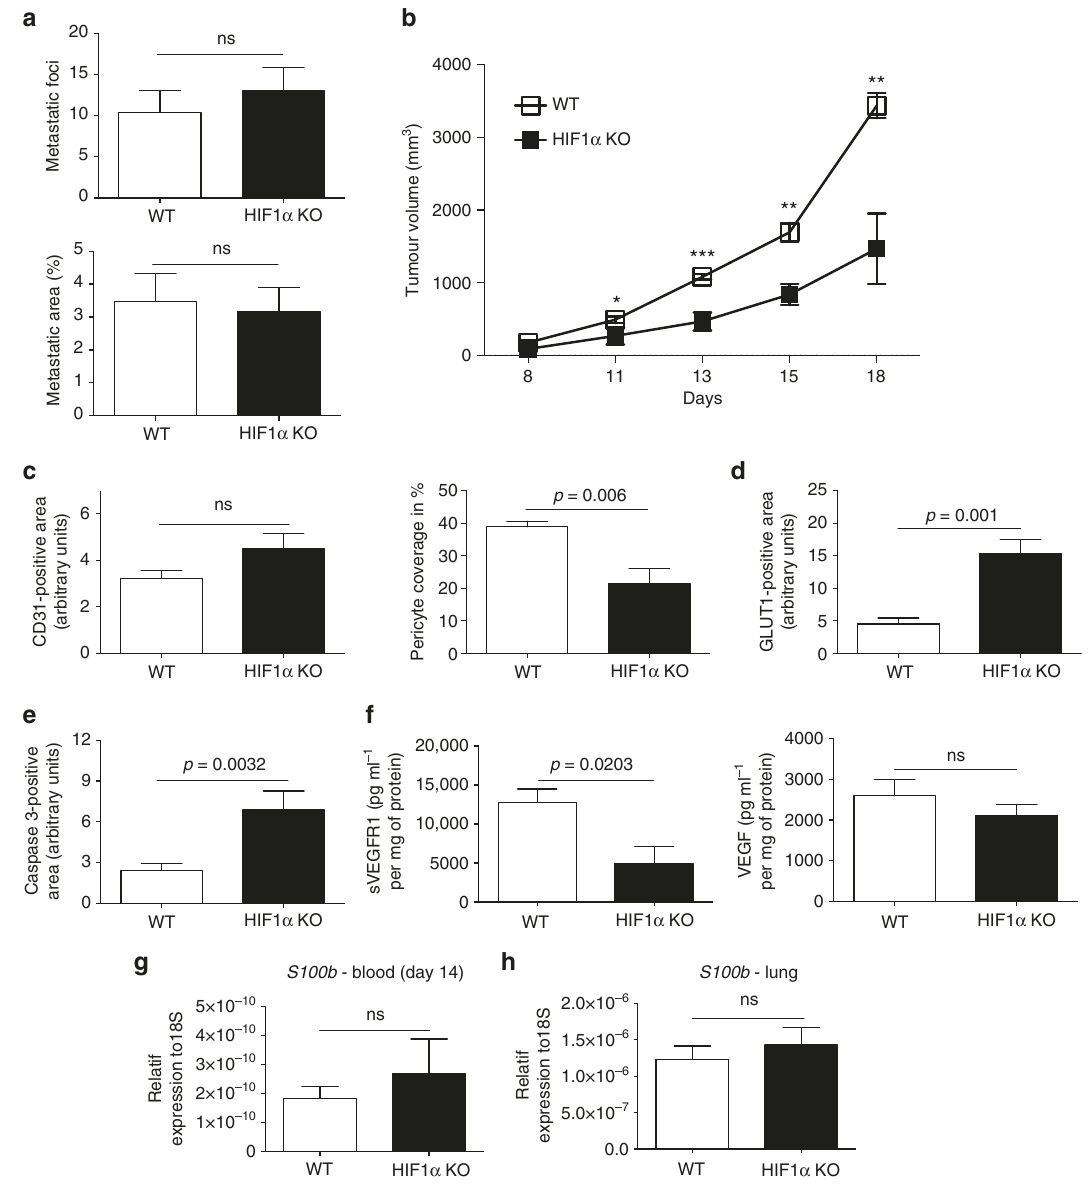
Fig. 6 NK cell HIF-1 α de fi ciency facilitates tumour cell intravasation and pulmonary metastasis. a The quanti fi cation of the metastatic foci and metastatic area in LLC tumour-bearing mice determined by H&E staining on 10 μ m lung paraf fi n serial sections at day 14 post tumour injection. b Tumour volume analysis of B16F10 melanoma isografts implanted in WT and HIF-1 α KO mice. c Quantitative analysis of CD31-positive endothelial cells and pericyte coverage as assessed by α -SMA/CD31 co-localisation at endpoint, day 14. d Quantitative analysis of hypoxic tumour areas with the speci fi c marker GLUT1 at endpoint, day 14. e Quantitative analysis of caspase-3-positive areas at endpoint, day 14. f Determination of levels of sVEGFR1 and VEGF protein in B16F10 melanoma isografts implanted in WT and HIF-1 α KO mice by ELISA at endpoint, day 18. g Gene expression analysis of the melanoma-speci fi c gene S100B in peripheral blood (day 14 post tumour inoculation) and h lungs from melanoma-bearing animals (at endpoint, day 18 post tumour inoculation) ( n = 10 for WT group; n = 6 for HIF-1 α KO group). Statistical signi fi cance was determined by an unpaired Student ’ s t -test or one-way analysis of variance, where appropriate. Bars represent mean values; error bars indicate the s.e.m. Statistical signi fi cance is indicated as * P < 0.05, ** P < 0.01, and *** P <